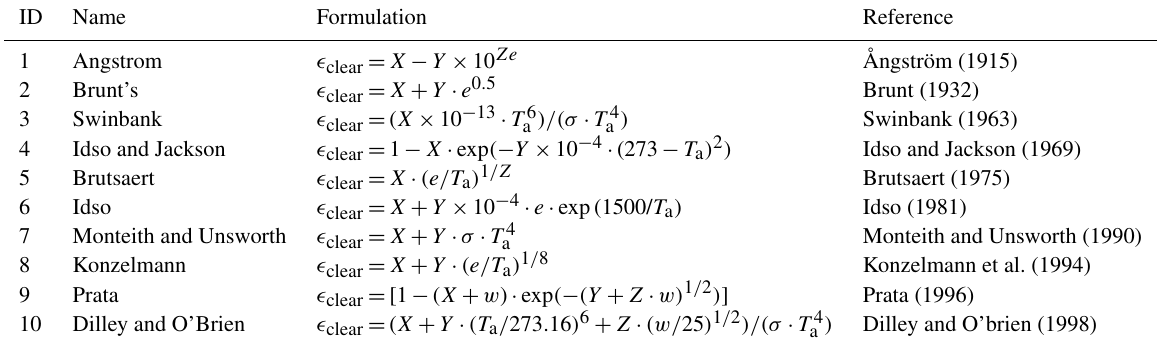
Table 1. Clear-sky emissivity formulations: T a is the air temperature (K), w (kgm − 2 ) is precipitable water = 4650 ( e 0 /T a ) and e (kPa) is screen-level water-vapour pressure. The models follow the formulations presented and used in Flerchinger (2000). The Angstrom and Brunt models were presented as cited by Niemelä et al. (2001). Konzelmann uses water vapour pressure in Pa, not kPa.